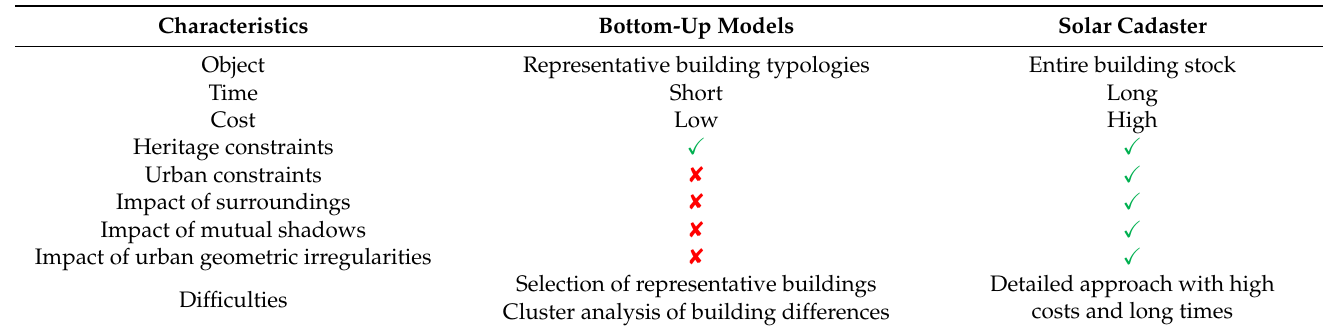
Table 3. Approaches used for the solar potential evaluation of architectural heritage (Source: Author’s